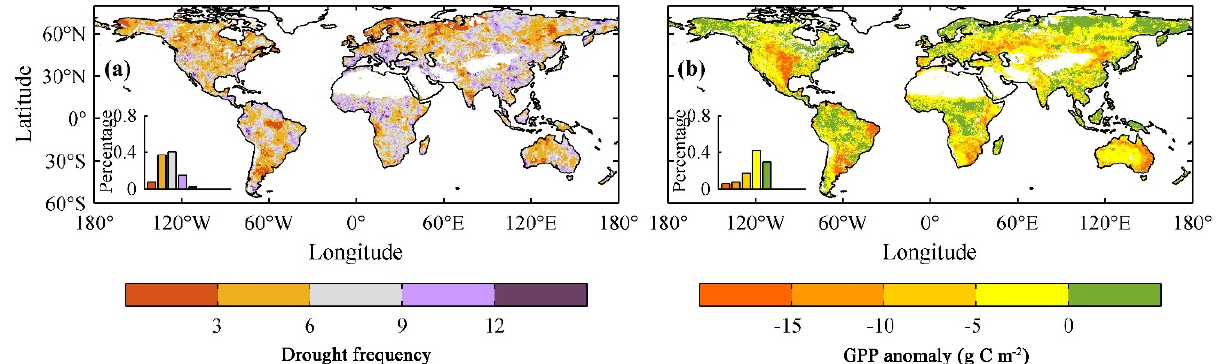
Figure 2. Drought frequency and LUE GPP changes’ spatial distribution during the drought period. ( a ) Geographical pattern of drought frequency from 1982–2015 (based on Standardized Precipitation Evapotranspiration Index (SPEI)–12 month). ( b ) GPP anomalies during drought period relative to non-drought period.